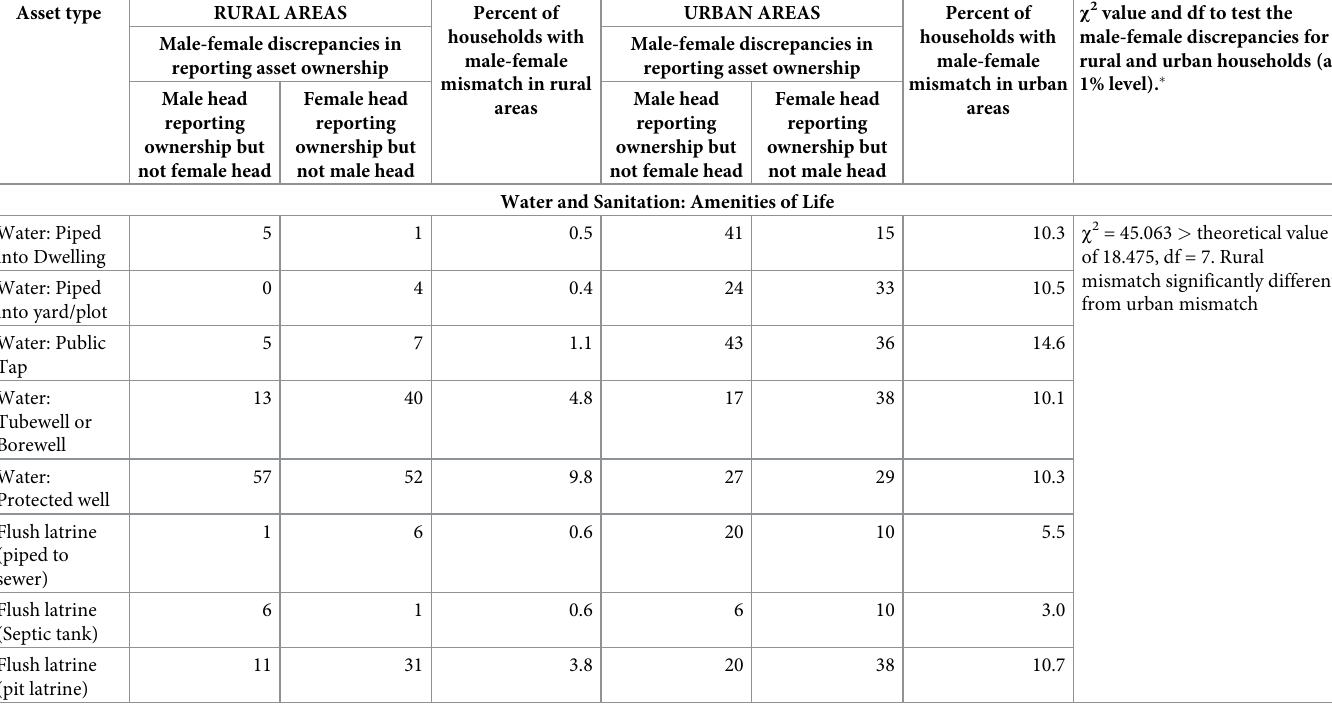
ð Asset score ; male (cid:0) Asset score ; female Þ D ¼ Asset score ; female